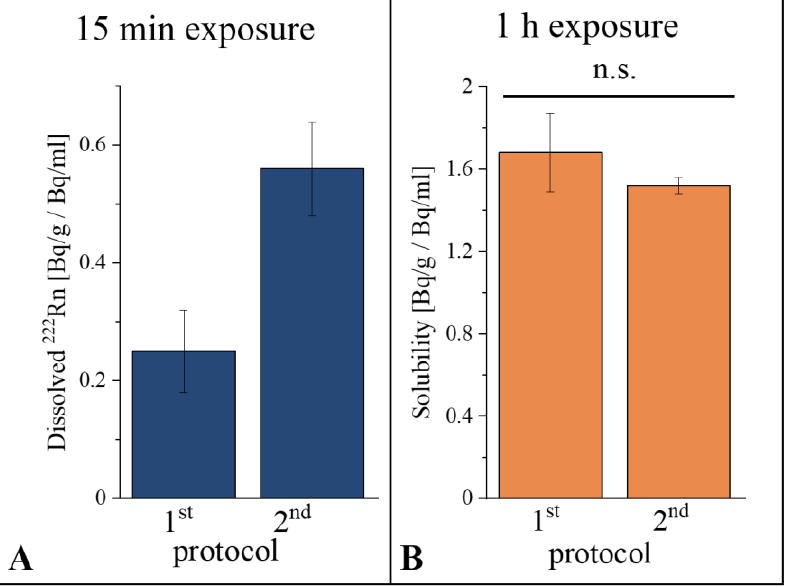
Figure 2. ( A ) Comparison of dissolved radon in oleic acid exposed to radon for 15 min with the first and second exposure protocols. The experiment was performed at a temperature of 295.7 ± 0.1 K and an air pressure of 1001 ± 3 mbar, with a radon activity concentration of 287 ± 22 kBq/m 3 . Values determined with the second setup showed about a factor of two-higher solubility. ( B ) Comparisons of the solubility data for oleic acid exposed to radon for 1 h obtained using the first and second exposure protocol. The solubility results using the two different protocols showed no significant difference. Experiments were performed at a temperature of 295.5 ± 0.4 K and at an air pressure of 1000 ± 9 mbar (with standard deviation). n.s.: not significant.